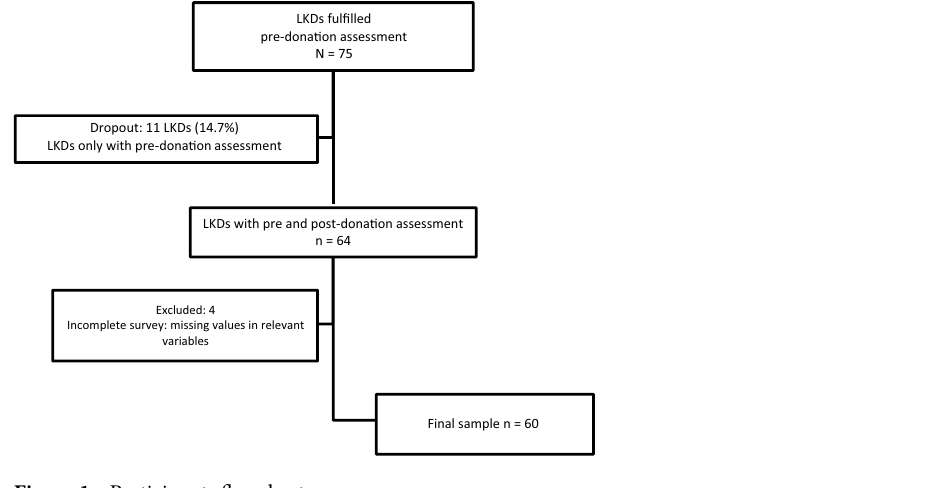
Figure 1. Participants